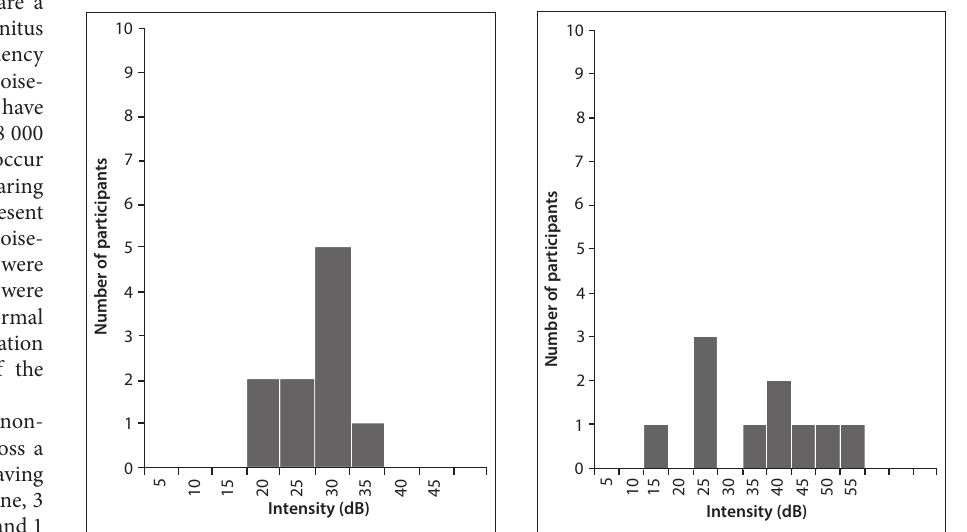
Fig. 3. Tinnitus loudness matching for group A. Fig. 4. Tinnitus loudness matching for group